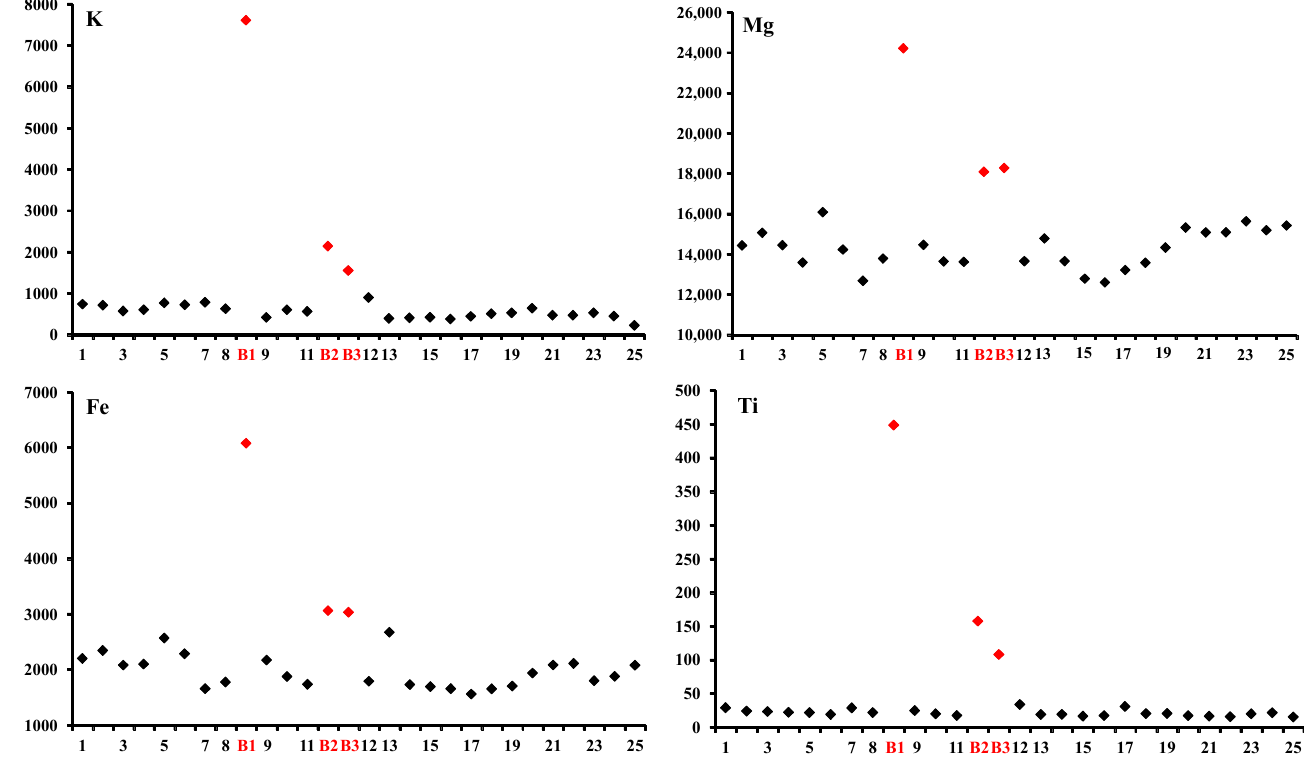
Figure 6. K, Mg, Fe and Ti as good indicators of biotite inclusion through zoning profiles of beryl from Wadi Nugrus, South Eastern Desert, Egypt.